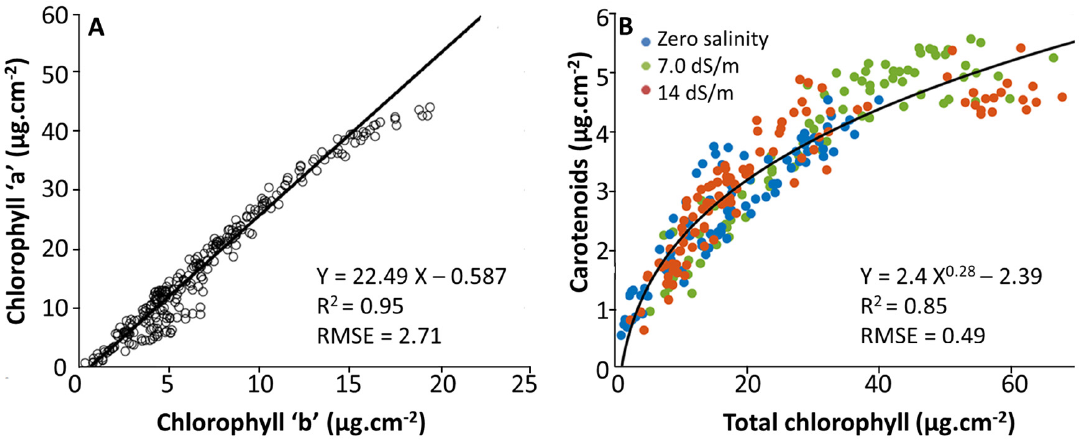
Figure 3. Relationship of the photosynthetic pigments in wheat leaves grown across gradients of soil salinity and fertilizer application: ( A ) linear relationship between chlorophyll “a” and chlorophyll “b” contents ( n = 277), and ( B ) relationship between total chlorophyll and carotenoids content ( n = 277) at various levels of salinity shown by different color markers. A second-order power curve best fitted to the data. The relationship coefficients and goodness of fit parameters are given in the plot area.